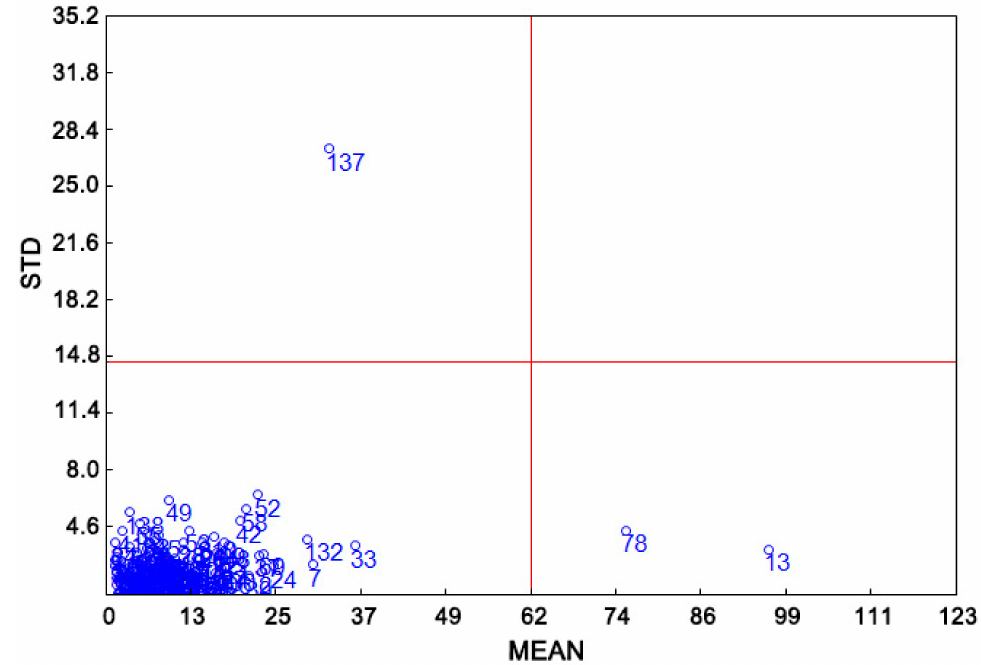
Figure 3. Outlier identification by using Monte Carlo cross-validation method.